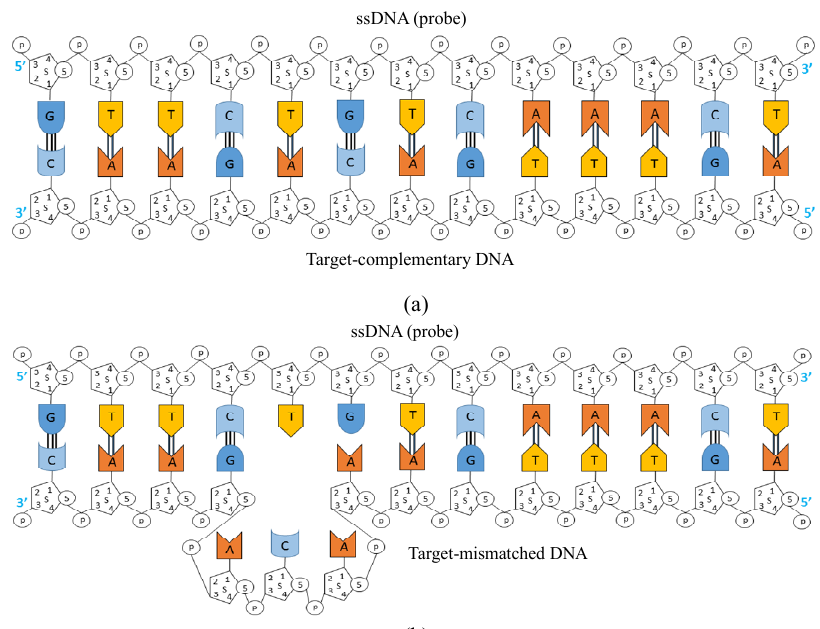
Fig. 2 Schematic of sequence orientation of adenine (A), thymine (T), guanine (G), and cytosine (C): (a) perfectly matched hybridization between shDNA and mrDNA sequences of BRCA1 gene (916delTT) and (b) mismatched hybridization between shDNA and wtDNA sequences of BRCA-1 gene (916delTT). Here, A-T bond by di-hydrogen bonding, G-C bond by tri-hydrogen bonding.